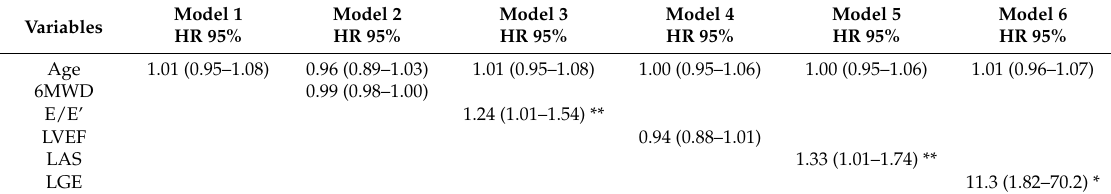
Table 5. Stepwise Multivariate Proportional Hazard Model for the Combined End Point.